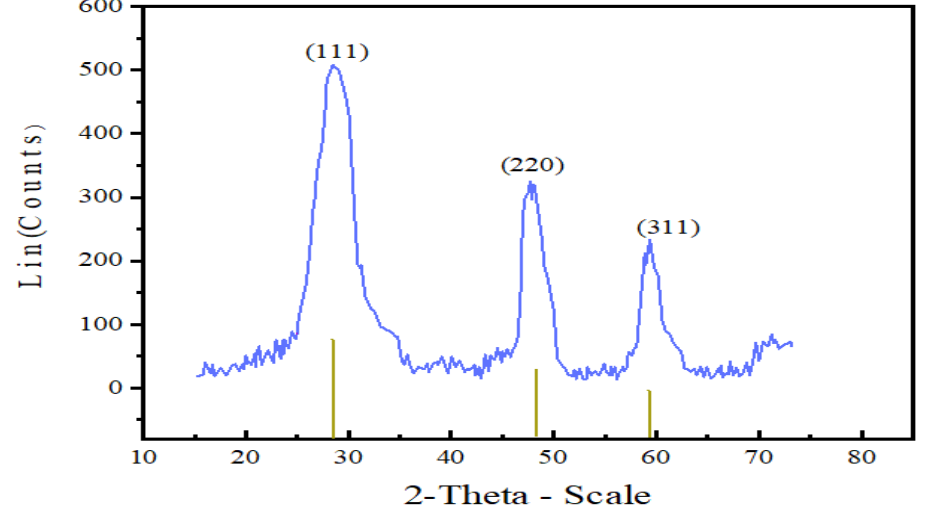
Figure 3. XRD diffractogram of Mn:ZnS QDs.